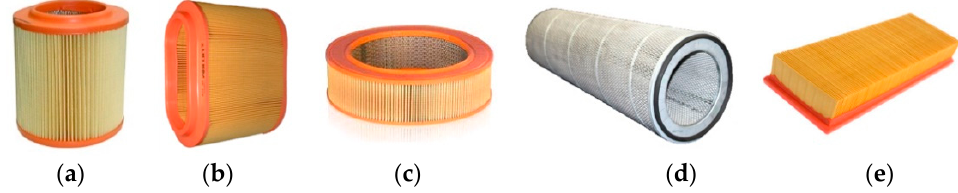
Figure 2. Types of paper air filter cartridges: ( a ) cylindrical with a circular base, ( b ) cylindrical with an oval base, ( c ) annular, ( d ) cylindrical conical, ( e ) panel.